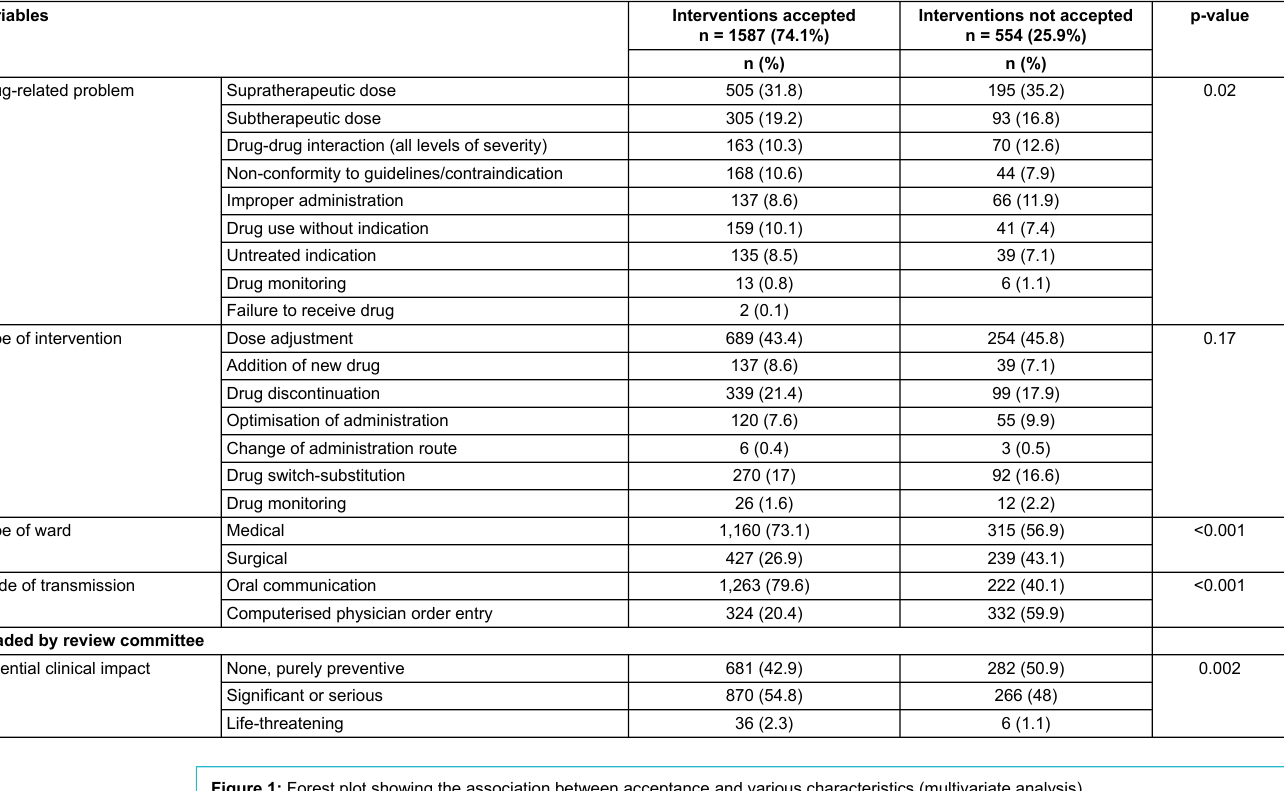
Figure 1: Forest plot showing the association between acceptance and various characteristics (multivariate